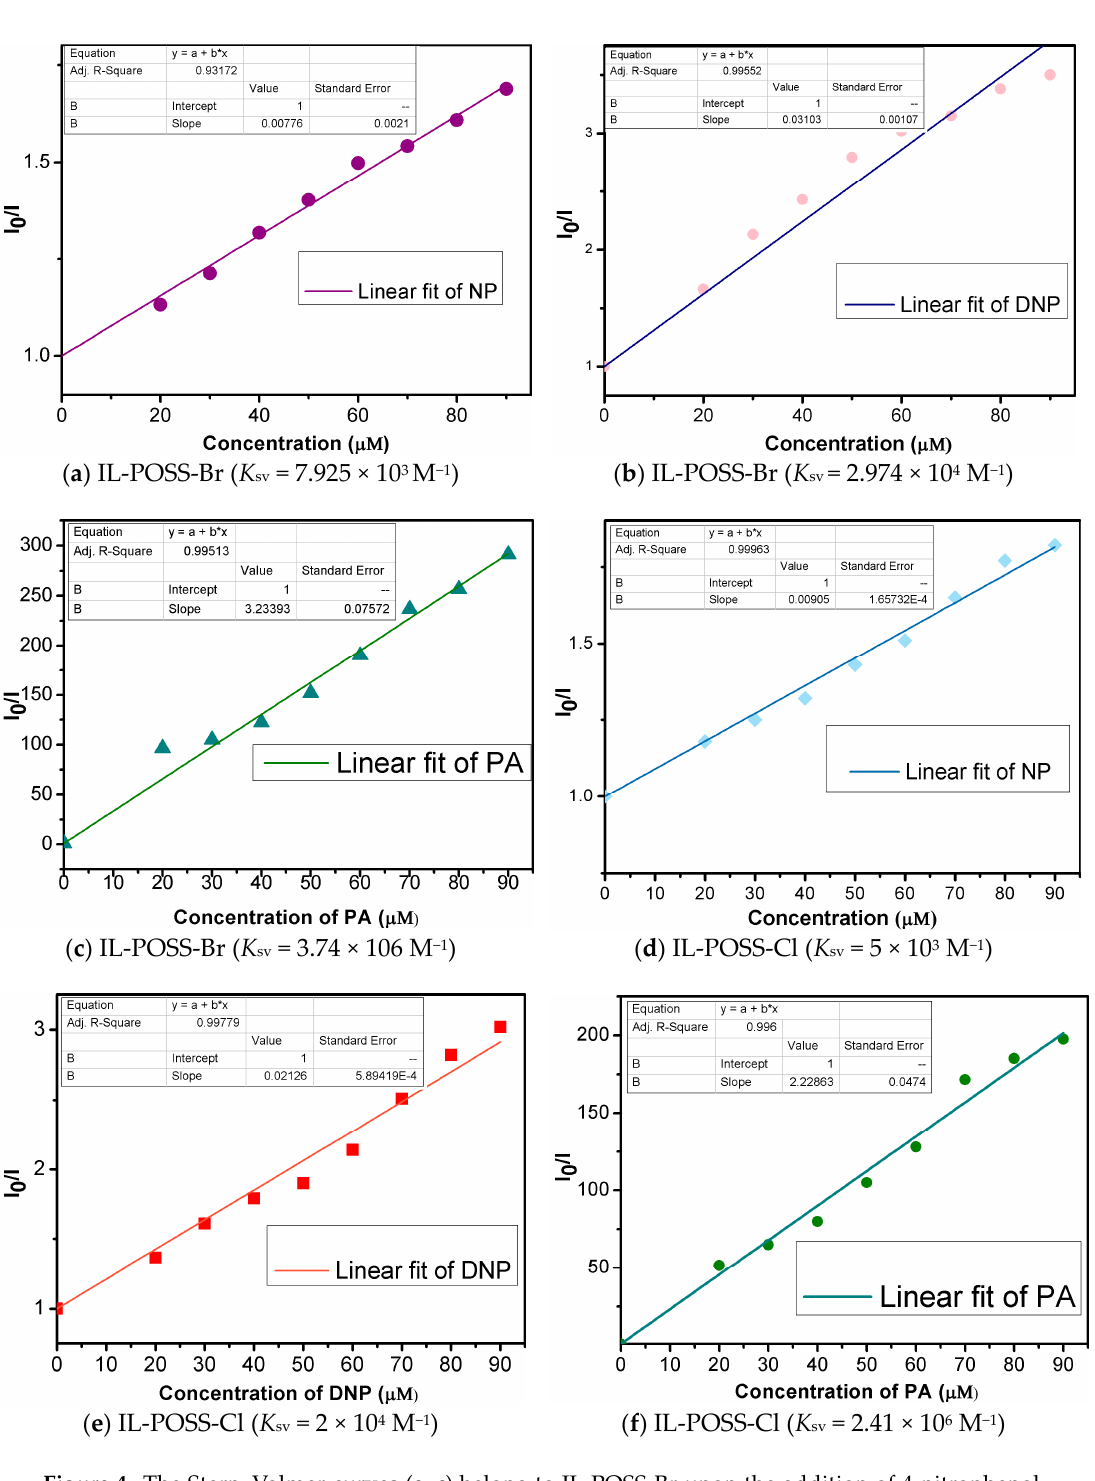
Figure 4. The Stern–Volmer curves ( a – c ) belong to IL-POSS-Br upon the addition of 4-nitrophenol, 2,4-dinitrophenol and picric acid ethanol solution, respectively. Emission spectra ( d – f ) belong to IL-POSS-Cl upon the addition of 4-nitrophenol, 2,4-dinitrophenol, and picric acid ethanol solution, respectively.